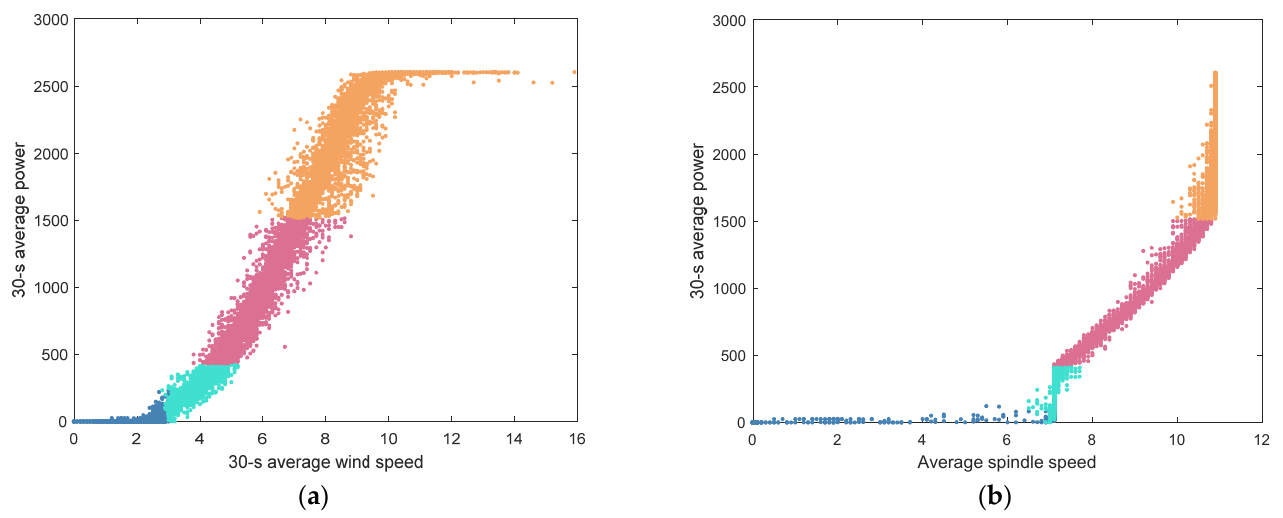
Figure 9. Preliminary working condition classification. ( a ) 30-s average wind speed vs. 30-s average power; ( b ) average spindle speed vs. 30-s average power.